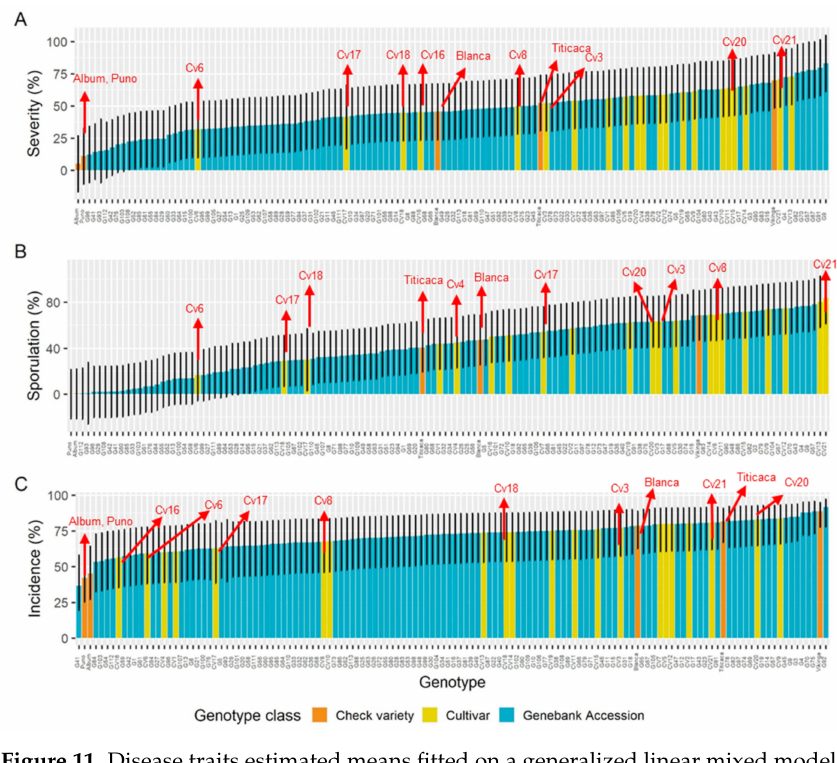
Figure 11. Disease traits estimated means fitted on a generalized linear mixed model (GLMM) for a diversity panel, comprising gene bank accessions (landraces), cultivars (Bolivian-bred cultivars), and check varieties (reference cultivars). ( A ) Severity of infection, ( B ) sporulation, and ( C ) incidence of infection. Error bars represent 95% confidence intervals. Adapted from Colque-Little et al. (2021)